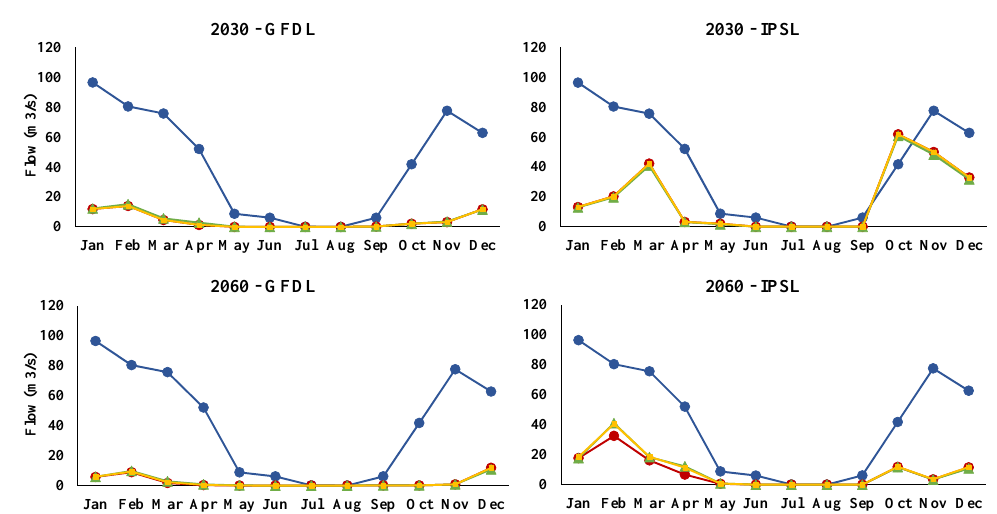
Figure 7. The monthly average of modelled river flow (m 3 s − 1 ) for each storyline and baseline. For clarification on the modelled scenarios, please see Figure 2. Table 5. The monthly averages for river flow (m 3 s − 1 ), total N (mg N L − 1 ), and total P (mg P L − 1 ) in each scenario.